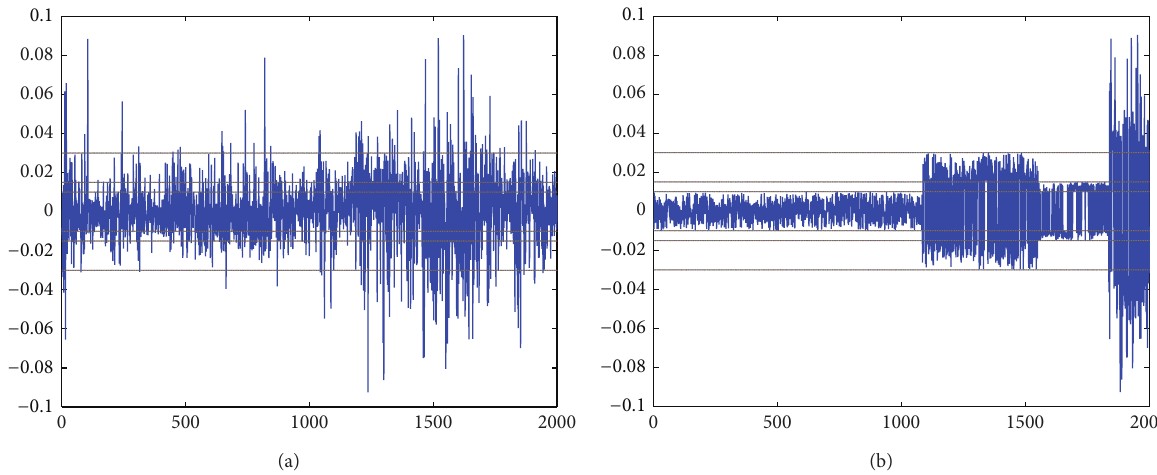
Figure 6: (a) The plot of an original return time series of SSECI; (b) the plot of the shuffled series return time of SSECI, that is, 𝑅 1 , 𝑅 3 , 𝑅 2 , and 𝑅 4 .